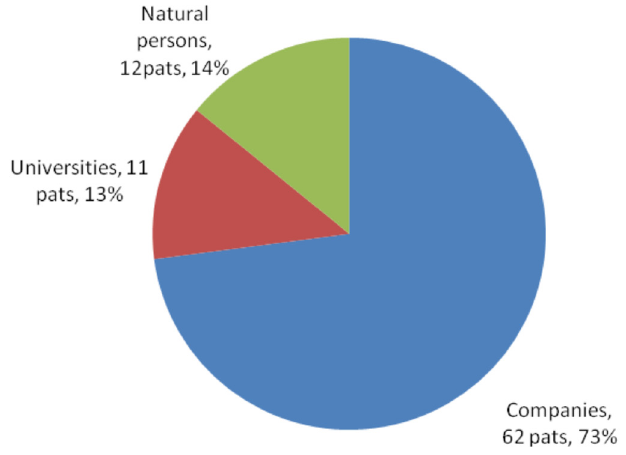
FIGURE 3 - Patent applicant types in INPI